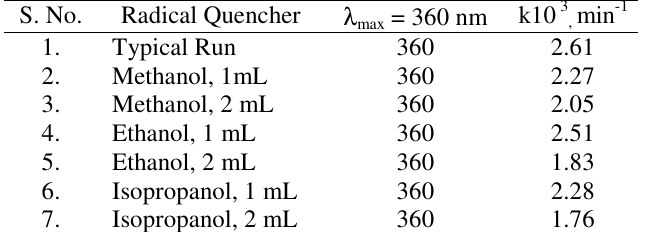
Table 7. Effect of radical quencher.